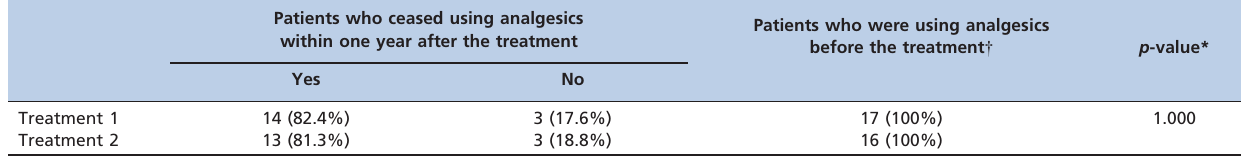
Table 6 - Frequencies and percentages of patients who had ceased using analgesics within one year after the treatment. Patients who ceased using analgesics Patients who were using analgesics within one year after the treatment before the treatment { p -value*